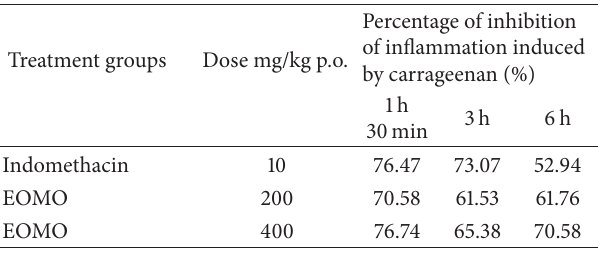
Table 2: Percentage of inhibition of inflammation of essential oil of Melissa officinalis L . using carrageenan-induced rat paw edema. Percentage of Treatment groups Dose mg/kg p.o.